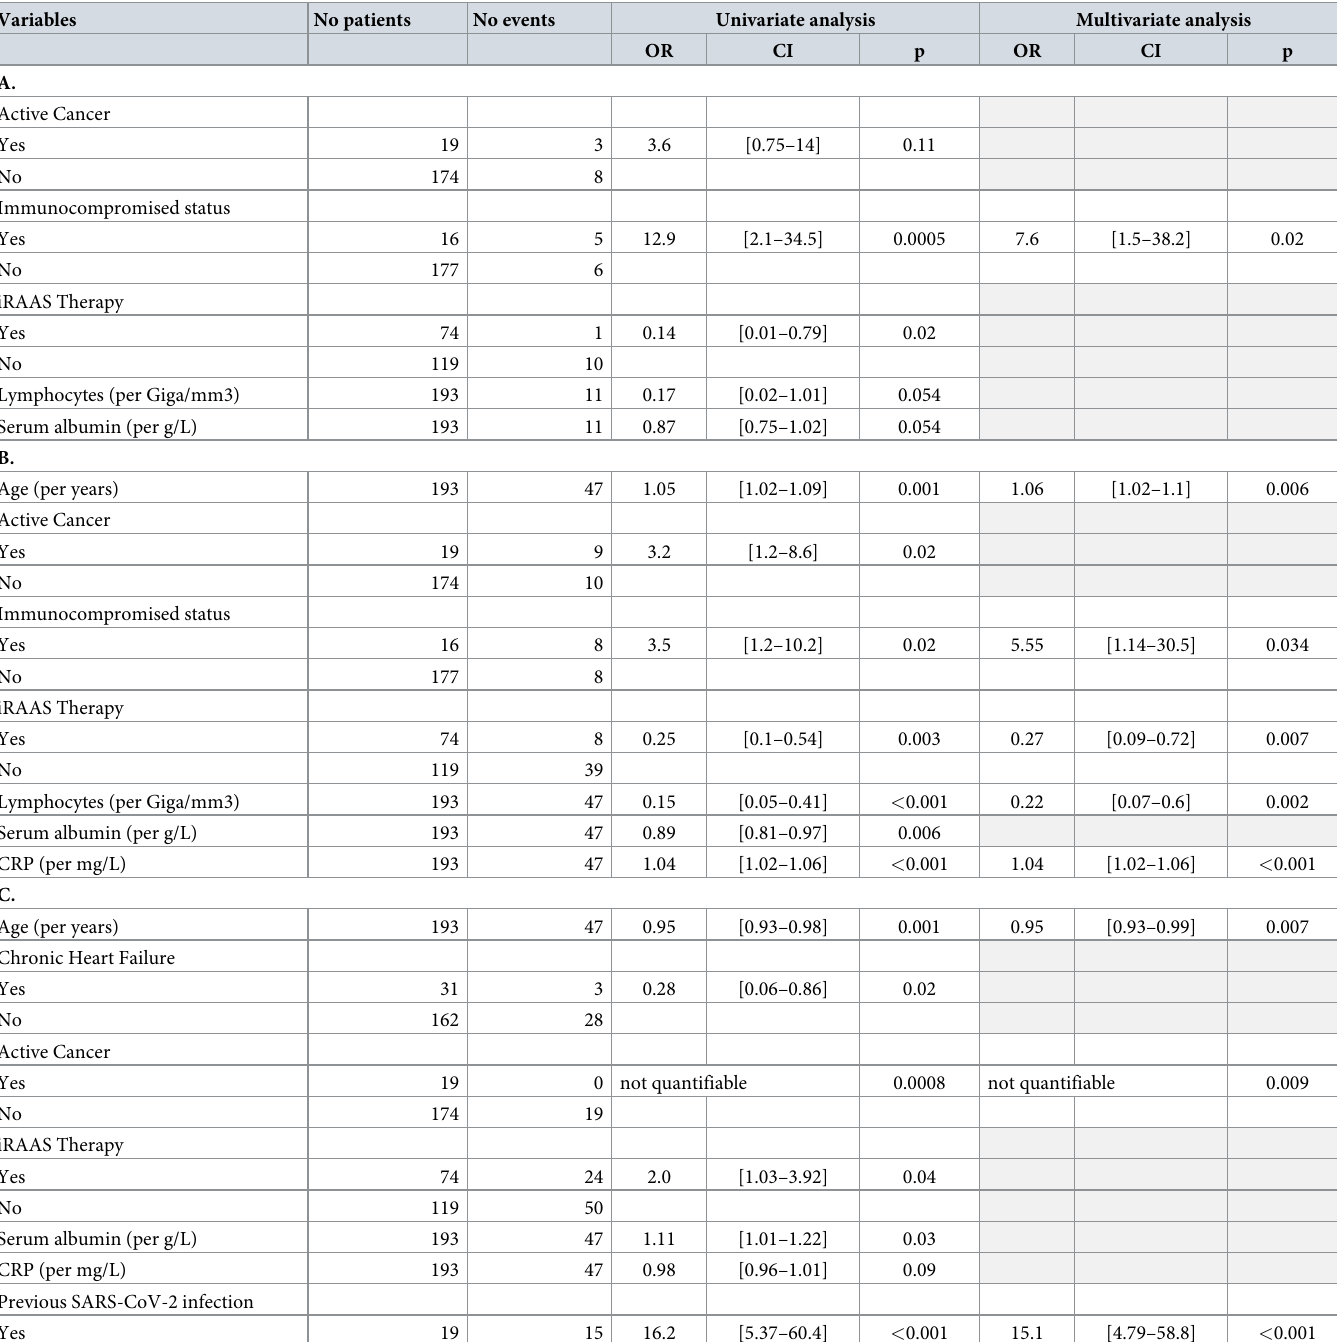
Table 2. A. Risk factors associated with the absence of seroconversion Spike-Protein-RBD IgG anti-SARS-CoV-2. B. Risk factors associated with a low Spike-Protein- RBD IgG anti-SARS-CoV-2 (IgG < 500AU/mL, first quartile vs other three quartiles). C. Risk factors associated with a high Spike-Protein-RBD IgG anti-SARS-CoV-2 (IgG > 7000AU/mL, Last quartile vs other three